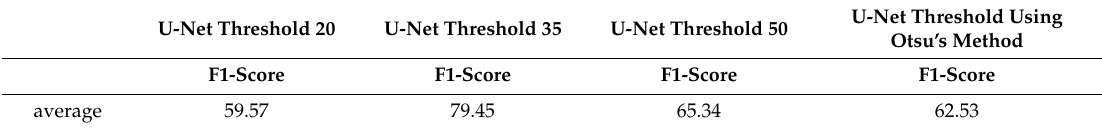
Table 3. Table showing the results of kidney detection in the CT images. The results were obtained by calculating the F1-score measure for the U-Net system. The threshold value T equals 20, 35, and 50 was used to obtain the results. On right column is threshold using Otsu’s